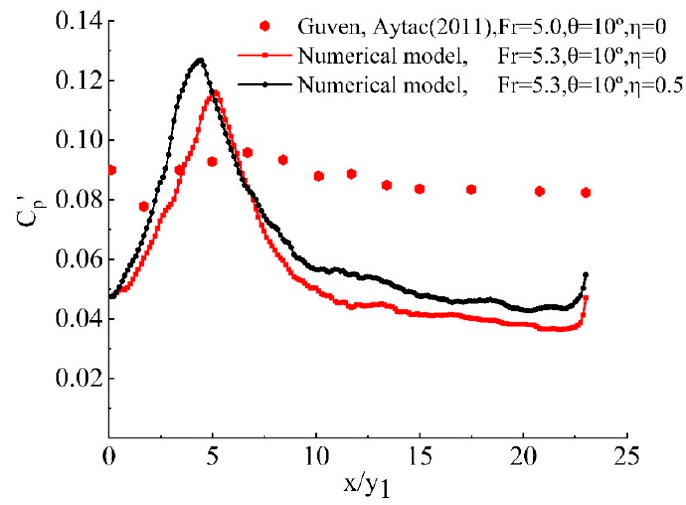
C ' ). Figure 13. Variance of fluctuating pressure coefficient (C p (cid:48) p